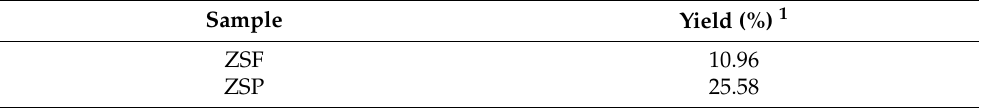
Table 1. Yield of each Zanthoxylum schinifolium extract. Sample Yield (%)